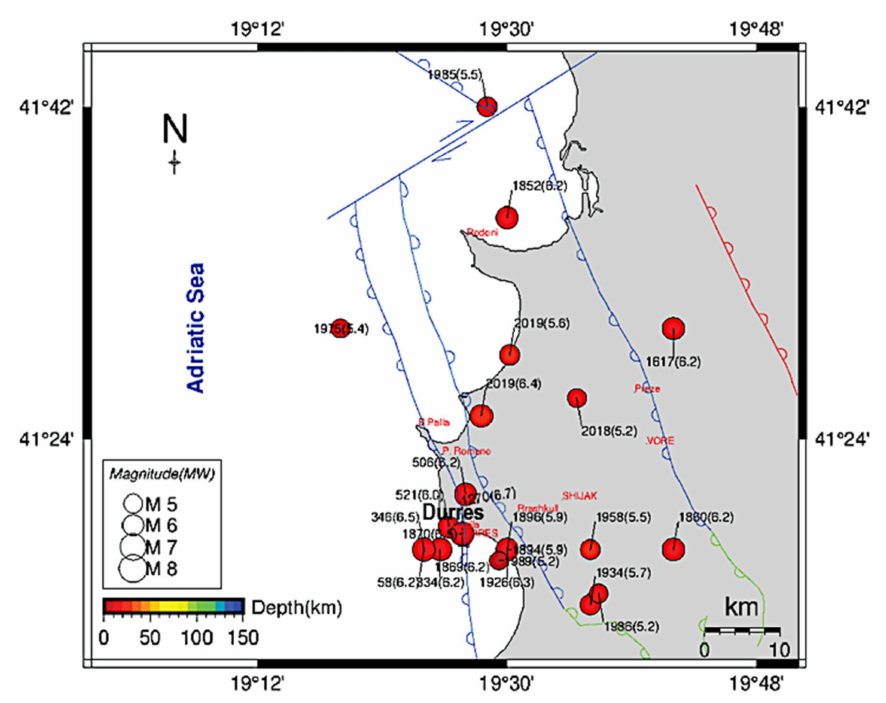
Figure 3. Historical and recent earthquakes affecting Durres and the surrounding region